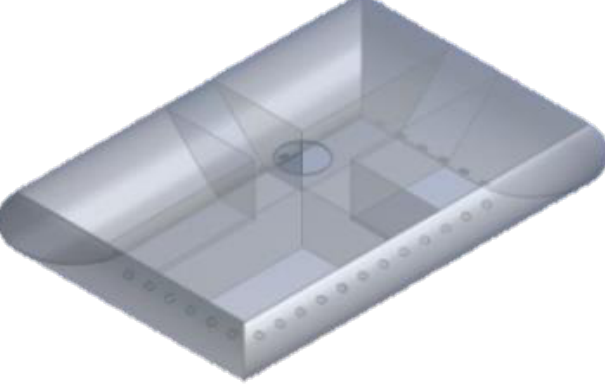
Figure 5. Isometric view of skirt domain